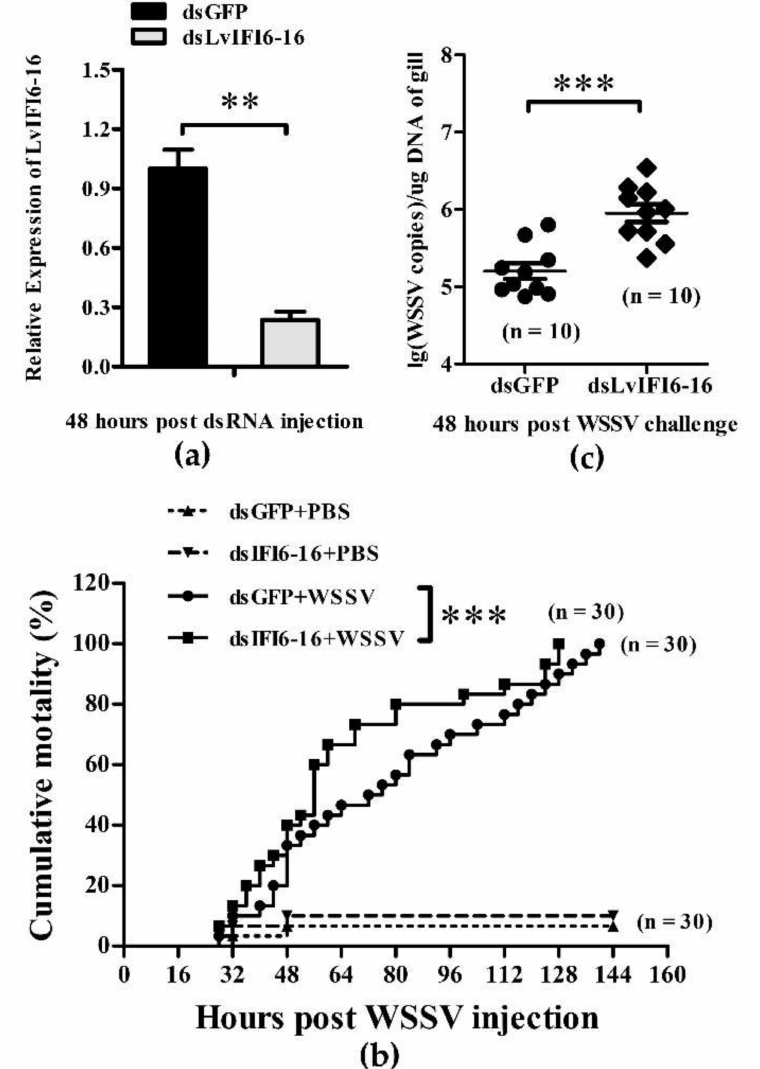
Figure 4. Functional analysis of LvIFI6-16 during WSSV infection. ( a ) Quantitative RT-PCR analysis of the silencing efficiencies of LvIF6-16. Bars indicated the mean ± SD of three samples and statistical significances were calculated by the Student’s t -test (** p < 0.01). ( b ) Cumulative mortality of LvIFI6- 16-silenced shrimps after WSSV challenge. Differences in cumulative mortality levels between treatments were analyzed by log-rank (Mantel-Cox) test (*** p < 0.001). Experiments were performed three times with identical results. ( c ) WSSV genome copies in gill tissue (1 g) of LvIFI6-16 dsRNA and GFP dsRNA treated shrimps at 48 h post infection. Bars indicate the mean ± SD and statistical significances were calculated by the Student’s t -test (*** p < 0.001). Experiments were performed three times with similar